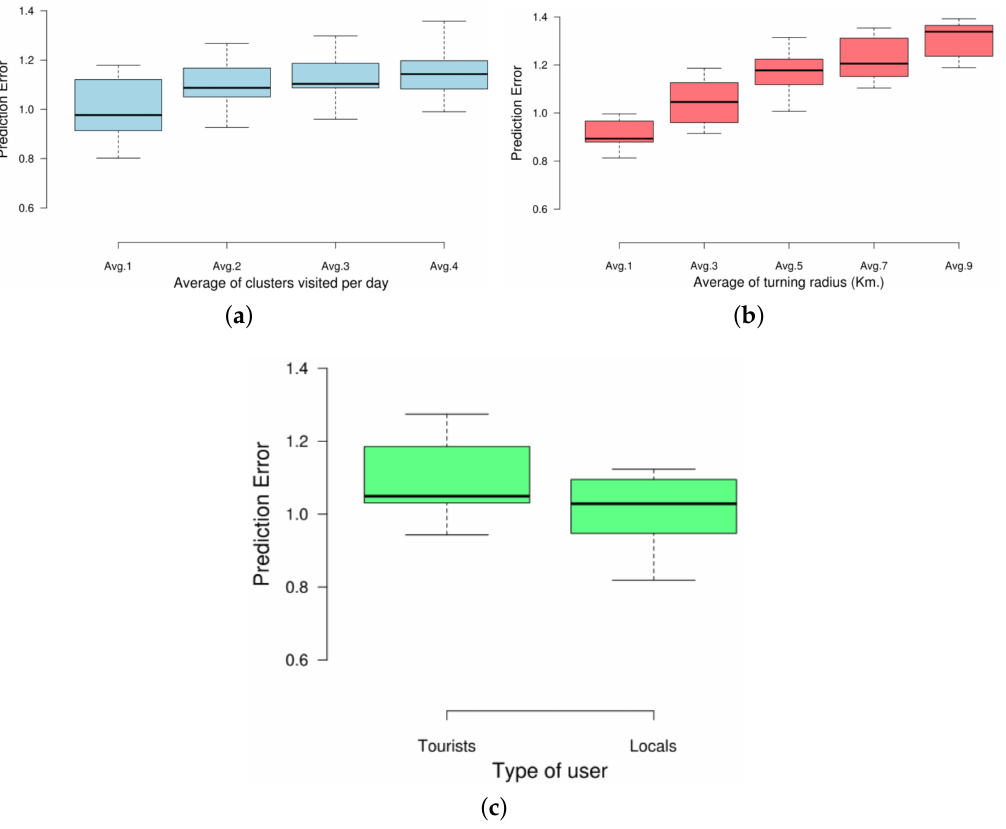
Figure 14. Prediction error of the predictor considering different factors related to users. ( a ) PE considering the avg. number of visited clusters per user per day; ( b ) PE considering the avg. radius of gyration of the target user’s trajectories; ( c ) PE considering tourist and resident users in NY and